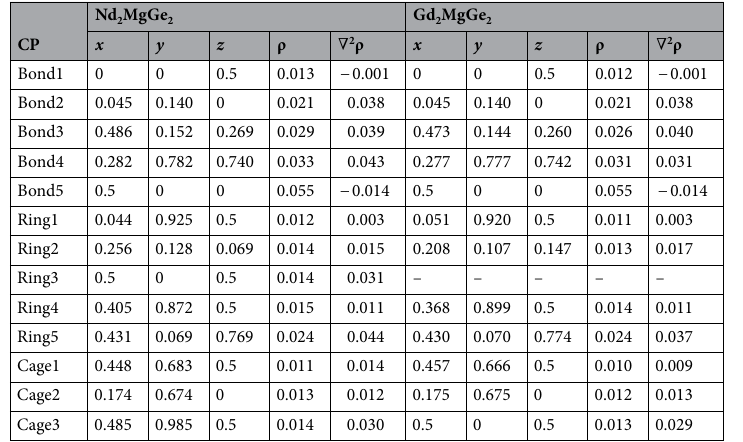
Table 3. CPs with charge density (ρ in electrons/Bohr 3 ) and its Laplacian ( ∇ 2 ρ in electrons/Bohr). The names refer to Fig.